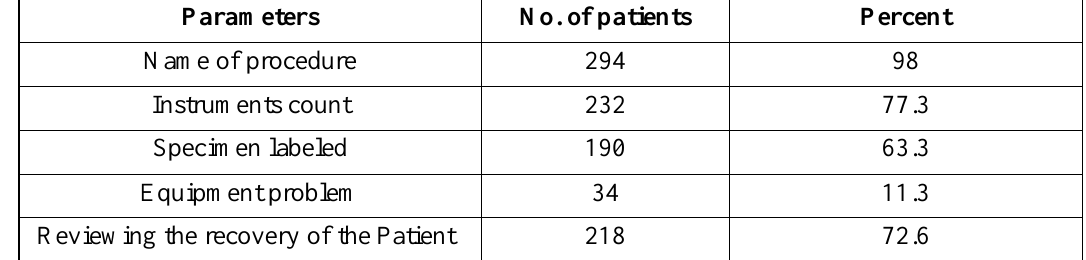
Table 3: Number of patients checked before patient leaving the operative room (N=300)